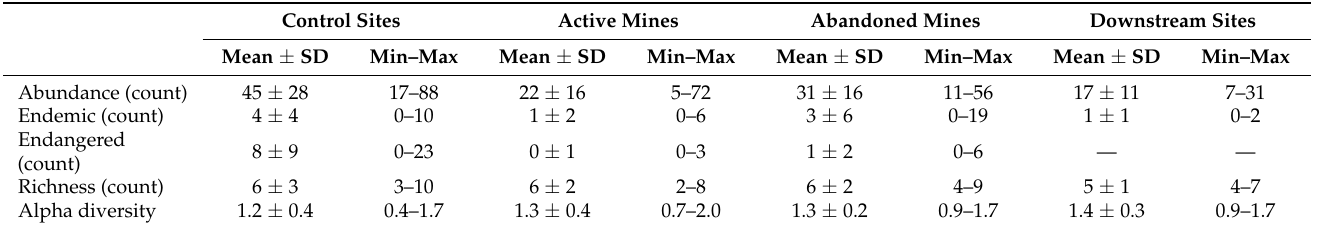
Table A4. Mean, standard deviation, and range of variation of fish richness, abundance, and alpha diversity at the study sites.